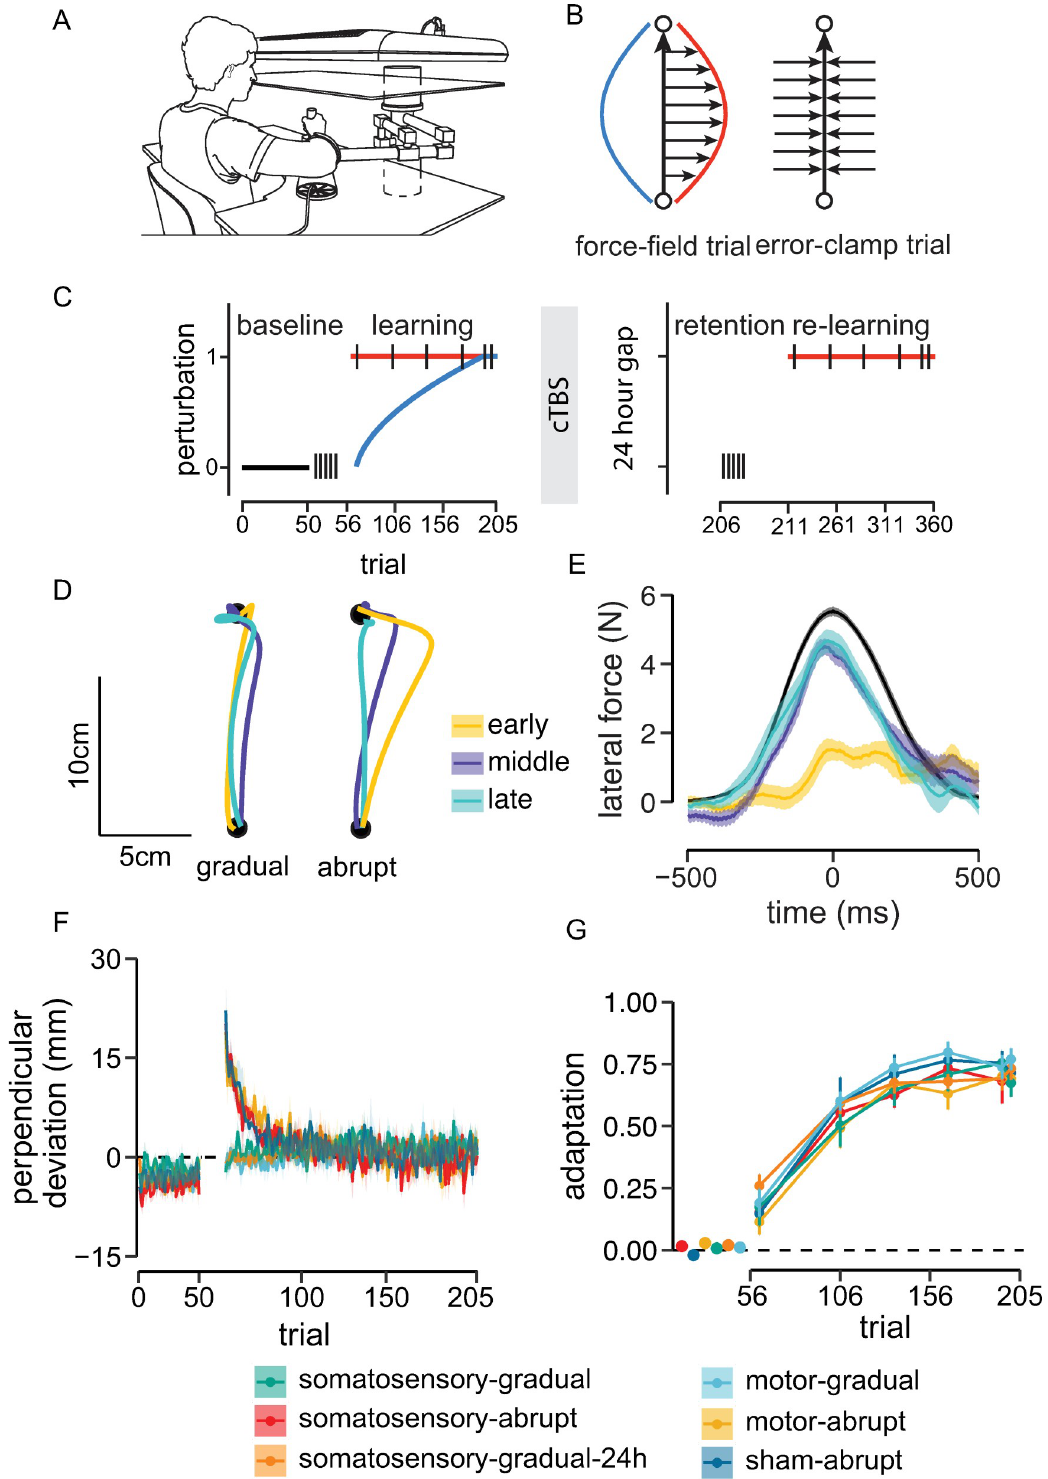
Fig 1. Experimental procedure and learning performance during day 1 training. (A) Sketch of the setup used to display the start and target positions, and a participant holding the robotic manipulandum. Sketch is adapted from van Vugt and colleagues [36]. (B) Schematic of force-field and error-clamp trials. The red curve exemplifies the force applied by the robot arm, and the blue curve illustrates the ideal compensatory force profile. In error-clamp trials, the robot constrained the hand movement to a straight